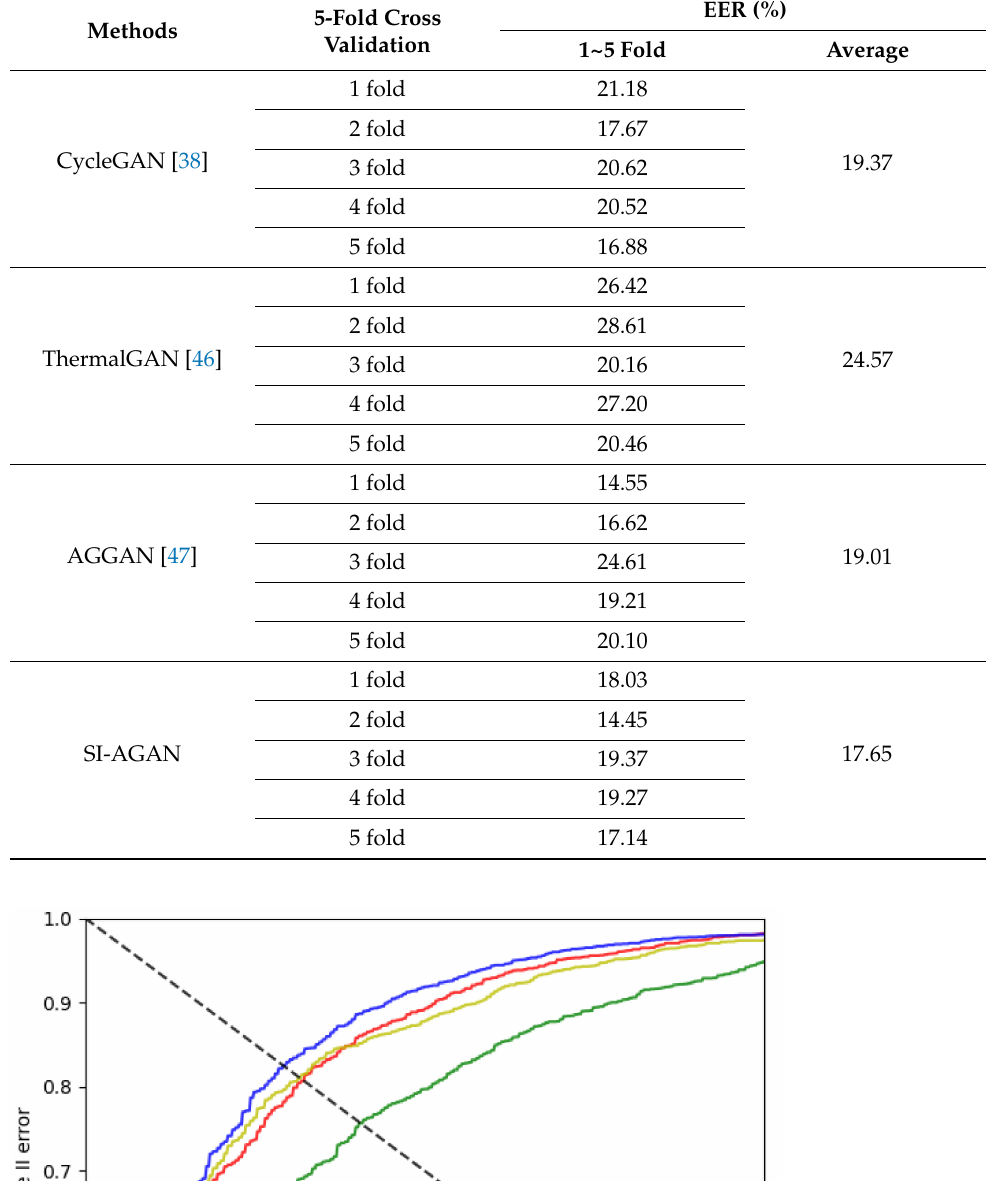
Table 10. Gender recognition accuracies of various style transfer methods.